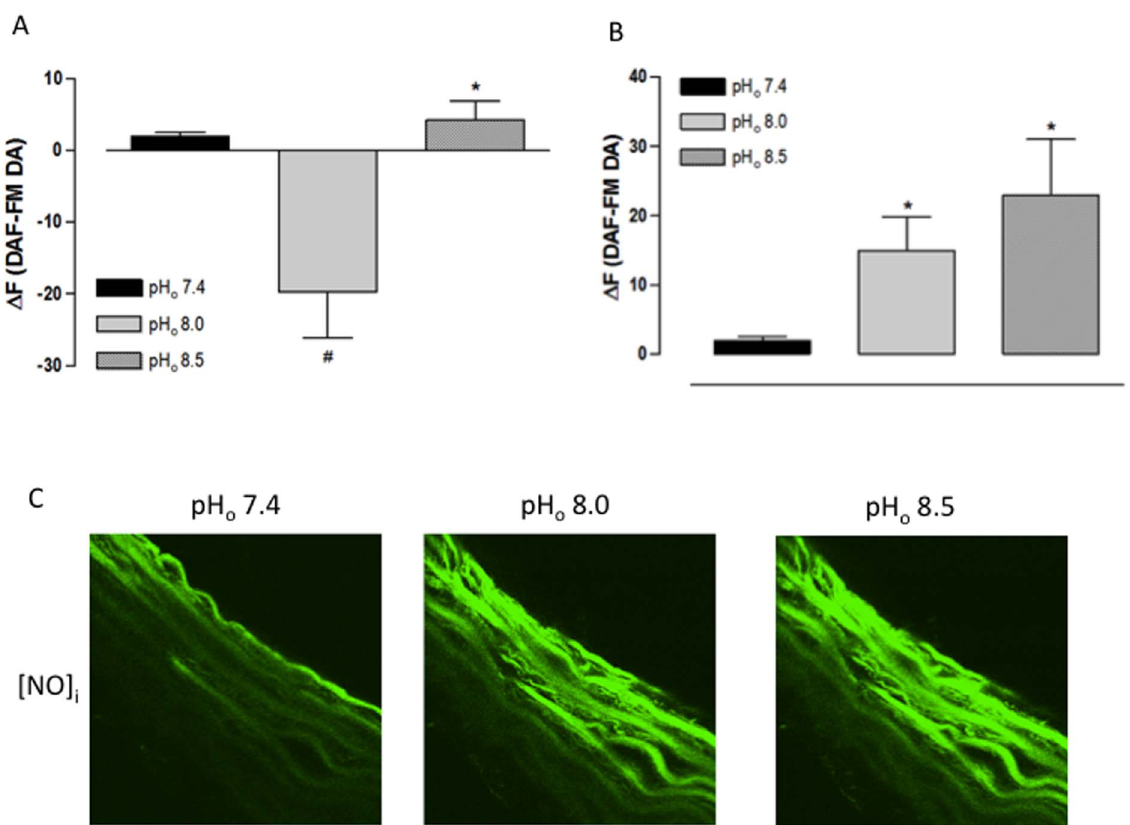
Figure 3. Effect of extracellular alkalinization on [NO] i of rat aorta cross sections assessed using a confocal scanning laser microscope. A) Fluorescence intensity for endothelial layer. B) Fluorescence intensity for muscular layer. C) Representative confocal photomicrograph of one aorta cross section.. Aorta cross sections were loaded with DAF-FM DA (5 m M) and analyzed by confocal microscopy. Aorta cross sections were stimulated at 3 rd and 9 th min with Hanks alkalinized solution pH 8.0 and 8.5, respectively. NaOH was used to change the pH of Hanks solution; Hanks solution pH 7.4 served as control. Fluorescence intensity was measured before the stimulus (F) and at 6 th min after the stimulus for each pH o value (F pH ). Results are reported as D F=F pH – F. All values are means 6 SEM (n=7). One-way ANOVA, Bonferroni’s post-test, # p , 0.001 versus control, * p , 0.05 versus control.